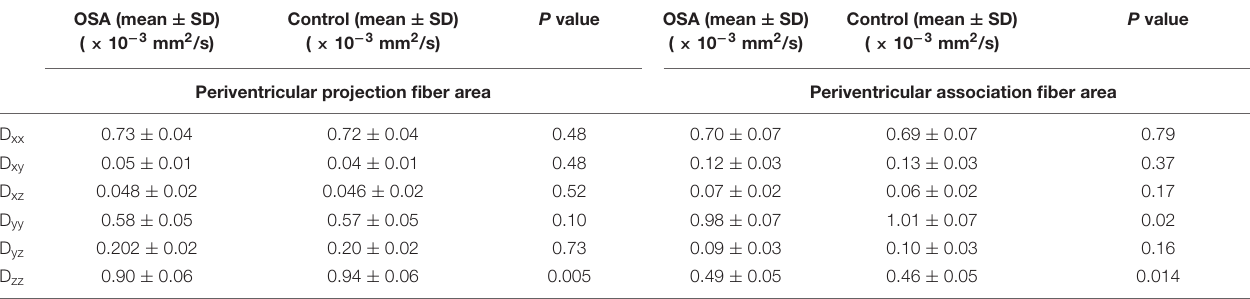
TABLE 3 | Diffusivity changes (corrected for age and sex with Bonferroni correction) in periventricular projection fiber area. OSA (mean ± SD) ( × 10 − 3 mm 2 /s)